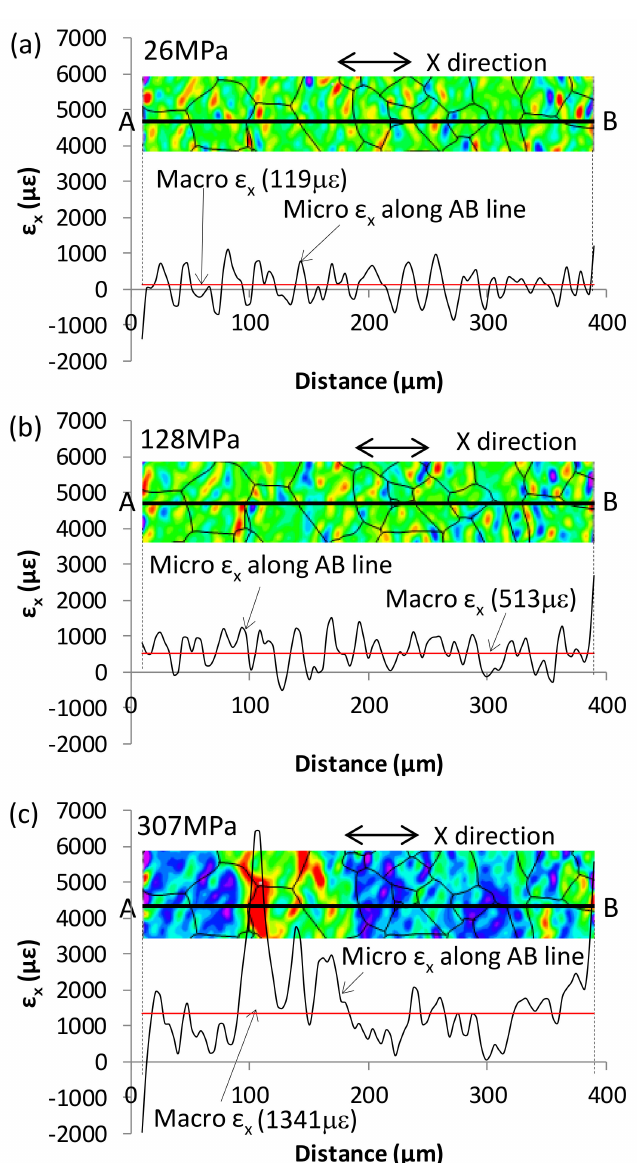
Figure 7. Microstrain distributions at di ff erent applied stresses along line AB. ( a ) applied stress 26 MPa and macrostrain 119 µε ; ( b ) applied stress 128 MPa and macrostrain 513 µε ; ( c ) applied stress 307 MPa and macrostrain 1341 µε . x direction is the tension